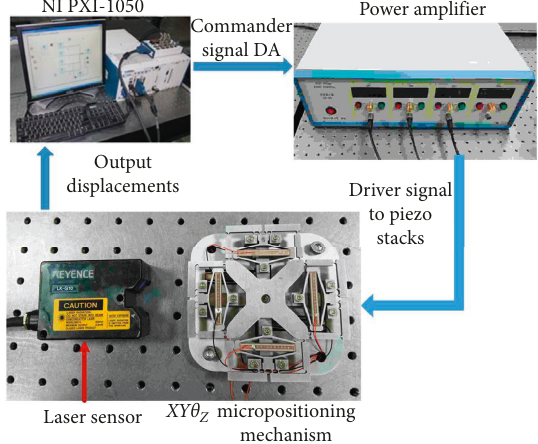
Figure 17: Principle and experimental setup of the mechanism.